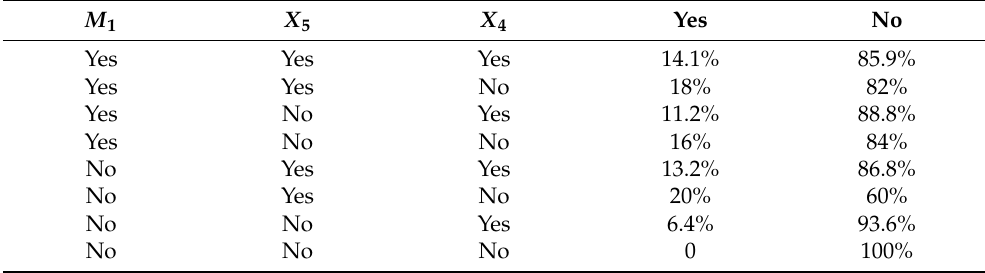
Table A9. Conditional probability distribution of T